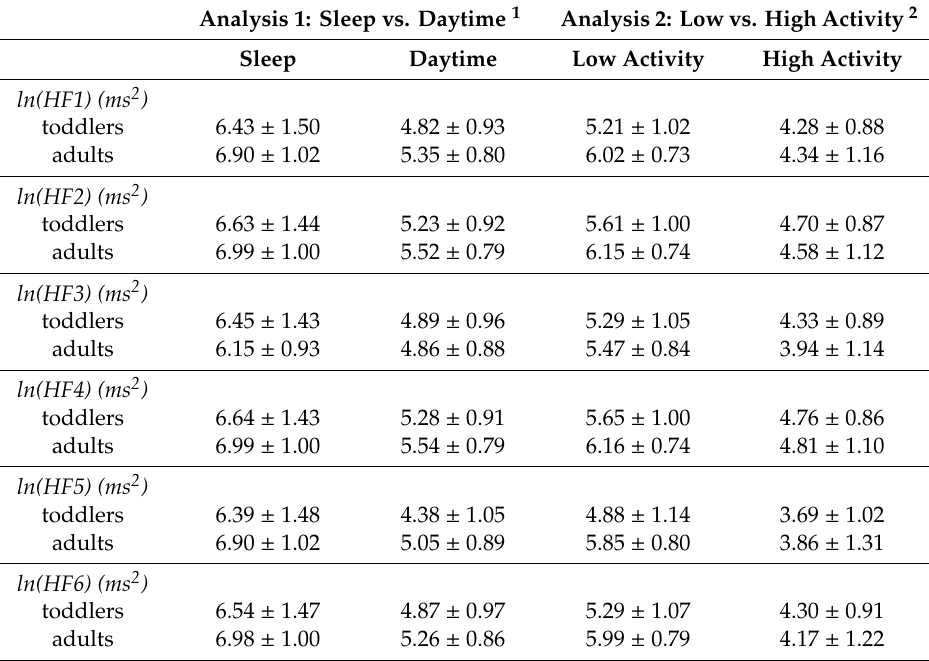
Table 3. Absolute band power in the predefined frequency bands (mean ±